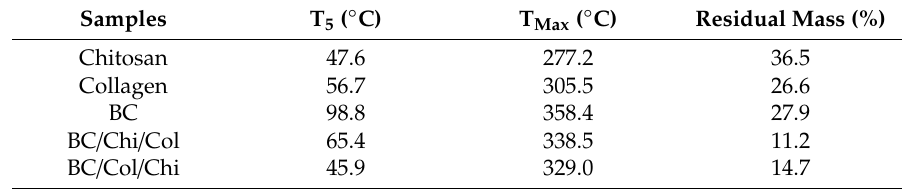
Table 3. T 5 , T max , and residual mass of chitosan, collagen, BC, BC / Chi / Col, and BC / Col /